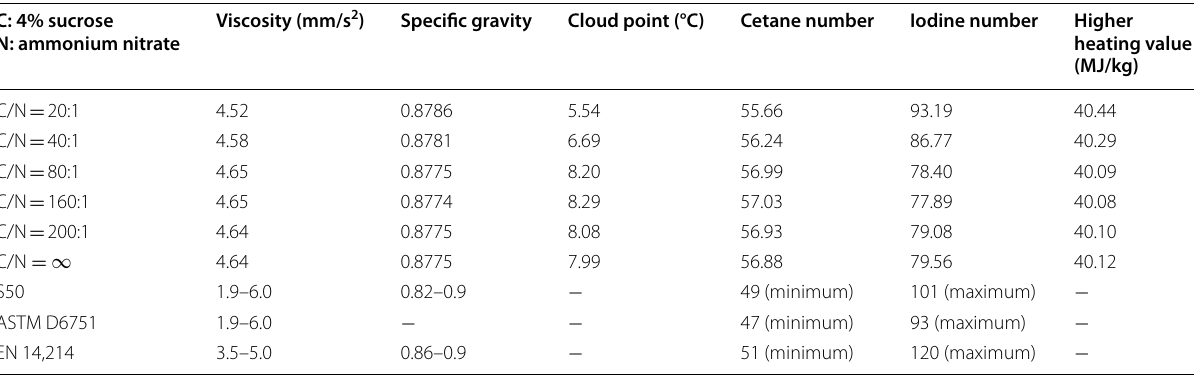
When 4% sucrose as the carbon source, ammonium nitrate as the nitrogen sources comparison of the properties of biodiesel for lipid by R-ZL2 fermented with different C/N ratios with those of Chinese, U.S. and EU biodiesel standards)